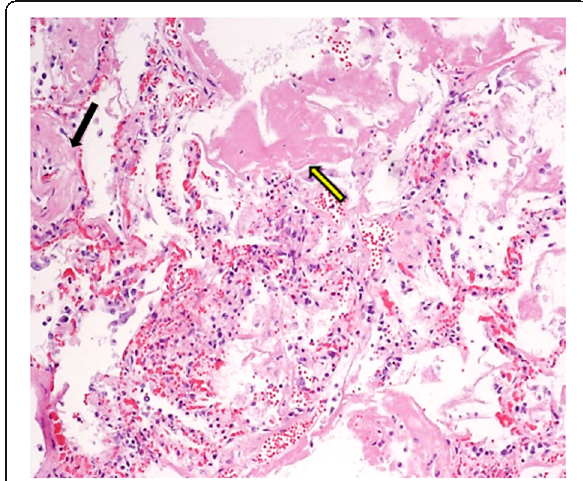
Fig. 3 DAD pattern with hyaline membrane and moderate fibrotic organisation (black arrow); presence of scattered large protein globules (yellow arrow). Expanded alveolar septa with inflammatory cells (hematoxylin and eosin stain, ×